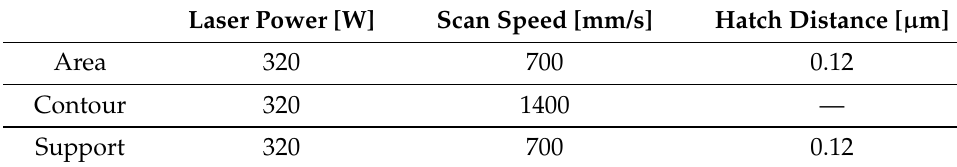
Table 1. Process parameters SLM.